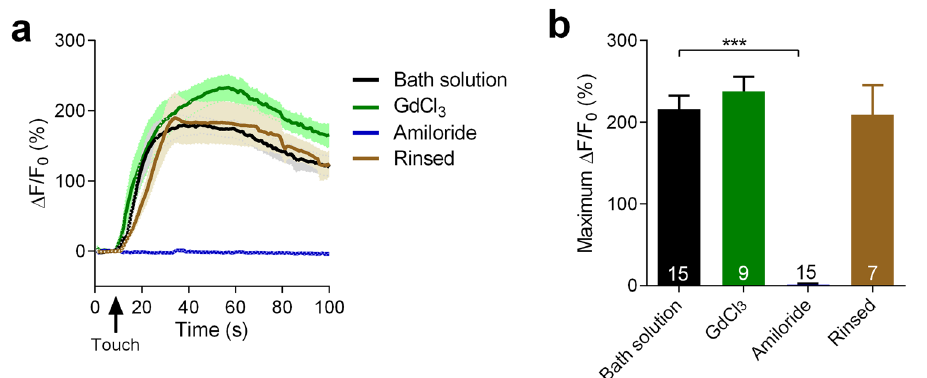
Figure 5. Amiloride blocks touch-induced calcium responses in RnB neurons. ( a , b ) Averaged calcium responses ( a ) and maximum Δ F/F0 changes ( b ) in R1B-R3B neurons induced by mechanical stimulation of 15 μ m displacement at the position of rays 1–3 in wild type worms with bath solution, GdCl 3 , amiloride or after rinsed amiloride out with bath solution. Solid lines show the average fluorescence changes and the shading indicates SEM. n ≥ 7. Data are mean SEM. *** P < 0.001, unpaired Student’s